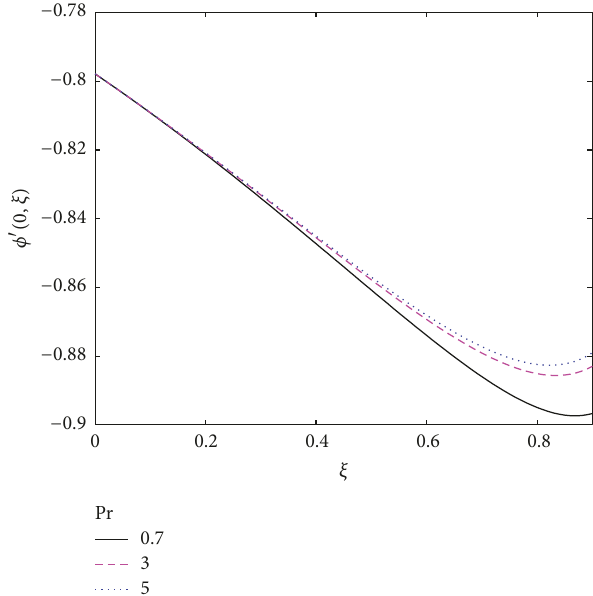
Figure 25: Effect of 𝛾 on 𝜙 󸀠 (0,𝜉) ( 𝜎 = 0.5, 𝜆 = 1, Pr = 3, Sc = 2, ℏ = −0.5 ).